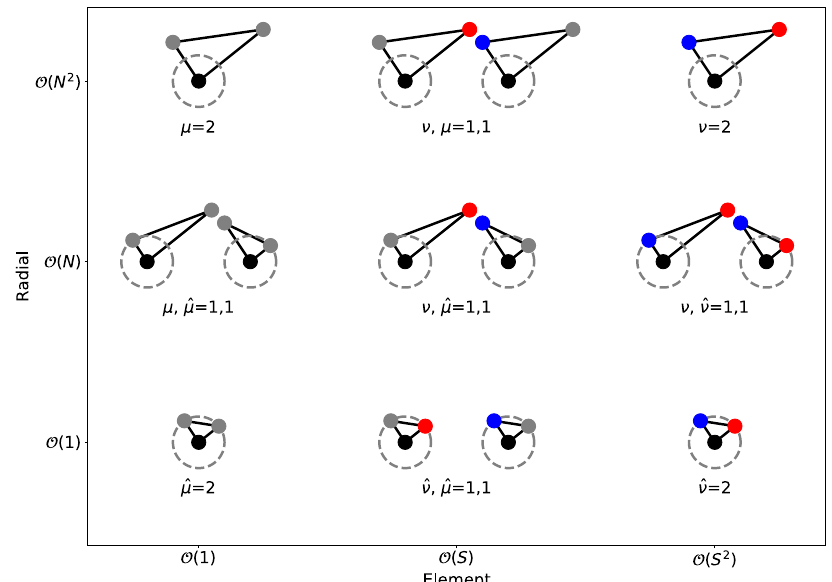
Fig. 2 Generalised SOAP power spectrum. Schematic showing the physical interpretation of the generalised power spectrum for various choices of ν , ^ ν , μ and ^ μ . For such 3-body terms ν þ ^ ν þ μ þ ^ μ ¼ 2 ; indices which are zero are not listed. The vertices shown in blue and red are element-sensitive whilst those shown in grey are not. The grey dashed line indicates the unit sphere. When the projection results in two distinct triangles both are shown, otherwise only one is